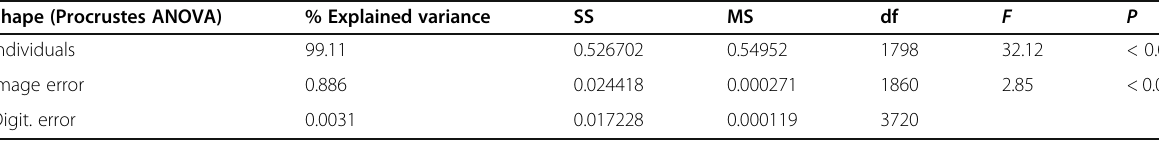
Table 1 Analysis of measurement errors for shape of P. pruinosus Shape (Procrustes ANOVA) % Explained variance SS